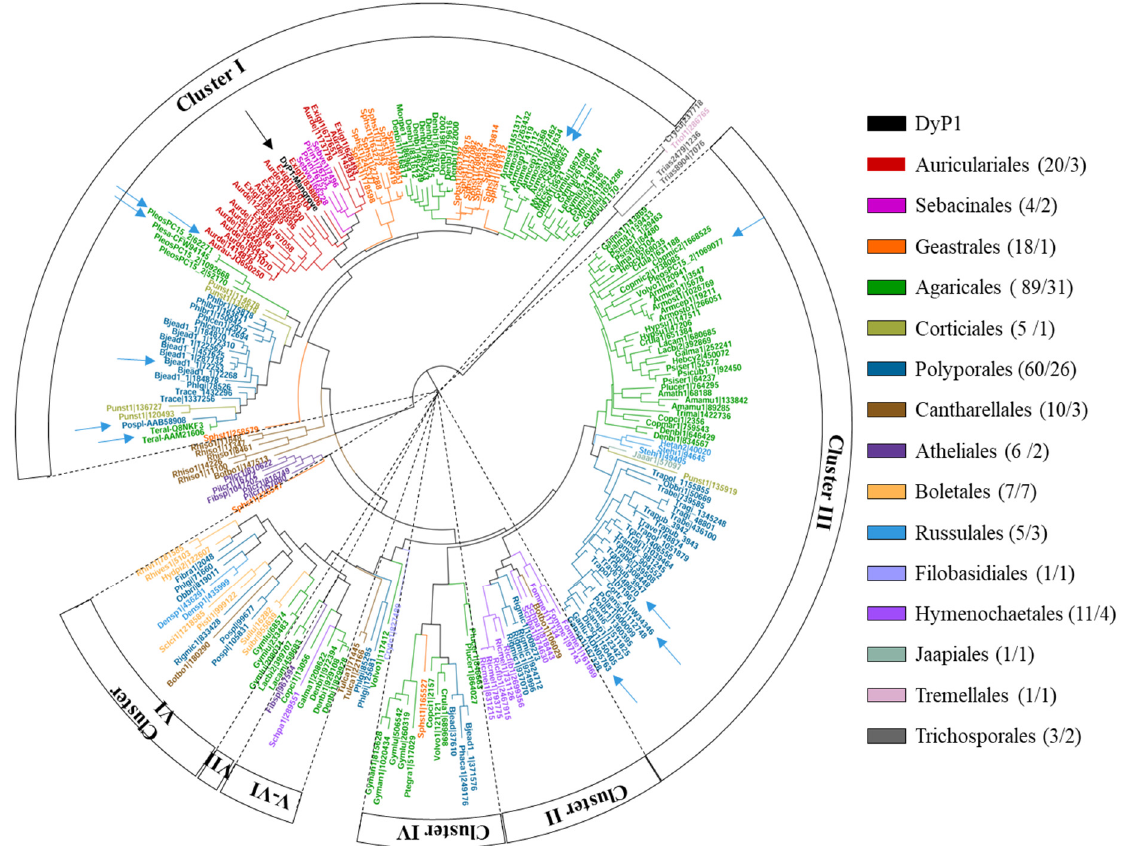
Figure 2. Maximum likelihood phylogenetic tree, constructed with 1000 bootstrap replications, showing the position of DyP1 from mangrove (black arrow) with respect to 233 DyP sequences identified in 82 published (and a few unpublished) Agaricomycotina genomes (the latter with permission of the PIs project) available at the JGI Mycocosm Portal on May 2020, including sequences of Pleurotus ostreatus (JGI 1069077 and JGI 62271), Bjerkandera adusta (JGI 72253), and Trametes versicolor (JGI 48870). Eight GenBank sequences from Auricularia auricula-judae (Aurau-JQ650250), Mycetinis scorodonius (Mycsc-CS490657 and Mycsc-CS490662), Ganoderma lucidum (Ganlu-ADN05763), Polyporaceae sp. (Pospl-AAB58908), Termitomyces albuminosus (Teral-AAM21606), Pleurotus sapidus (Plesa-CFW94145), and Coriolopsis trogii (Cortr_AUW34346) are also included. The color of both branches and enzymes indicates the order of the fungal species they belong to according to the legend, where the total DyP cDNA number is shown (including eight from GenBank) followed by the number of genomes for each order. The positions of the characterized DyPs from A. auricula-judae, B. adusta, Polyporaceae sp. (Irpex lacteus), M. scorodonius , T. albuminosus, P. ostreatus, T. versicolor, P. sapidus, and C. trogii are indicated with blue arrows.